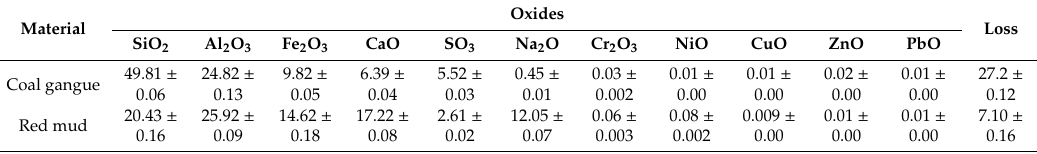
Table 3. Chemical compositions of coal gangue and red mud (wt%, mean ± SD, n = 3). Material